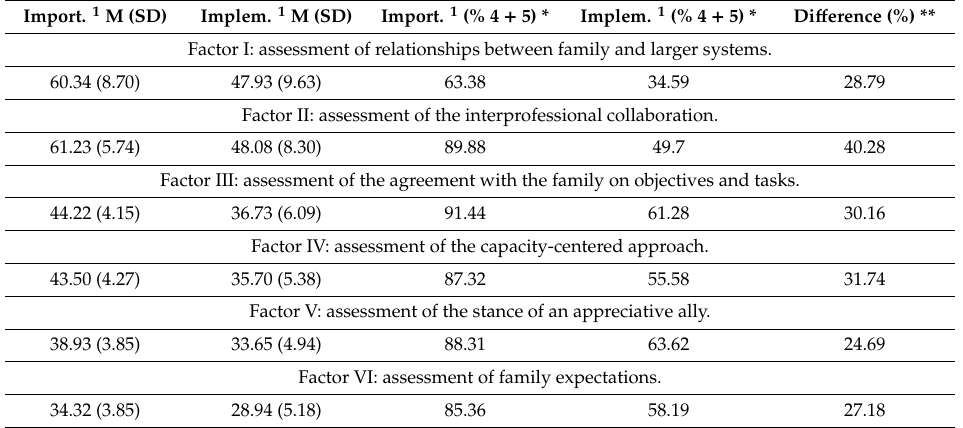
Table 1. Descriptive statistics of the Inventory’s